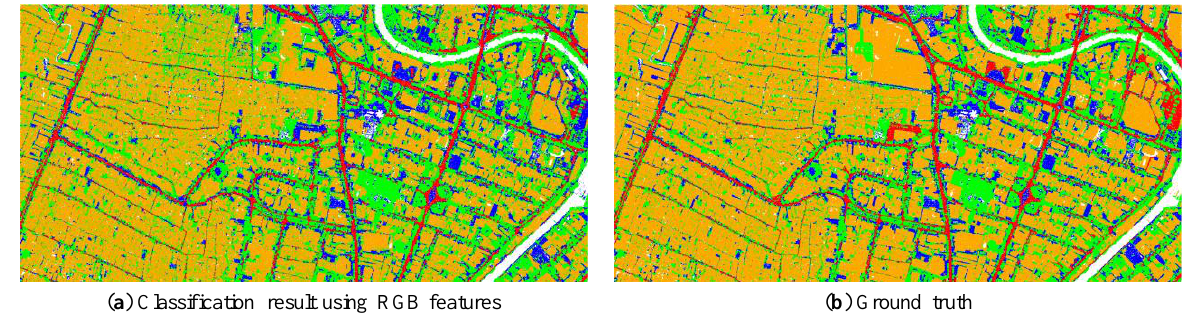
Figure 5. Semantic segmentation result over the test set area in comparison to the ground truth. Blue points represent bare- land, orange represents building, green represents vegetation, and red represents